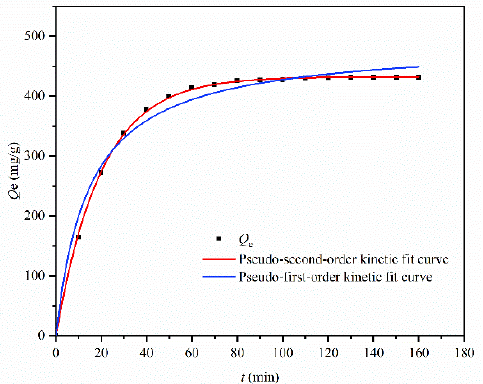
Figure 12. Pseudo-first-order and pseudo-second-order nonlinear fitting of dynamics. Table 4. Copper ion adsorption kinetic parameters of